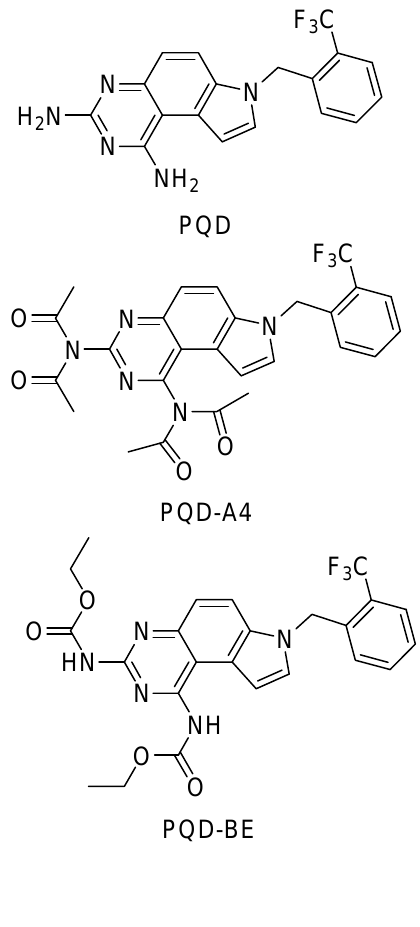
Figure 28. Chemical structures of PQD, PQD-A4 and